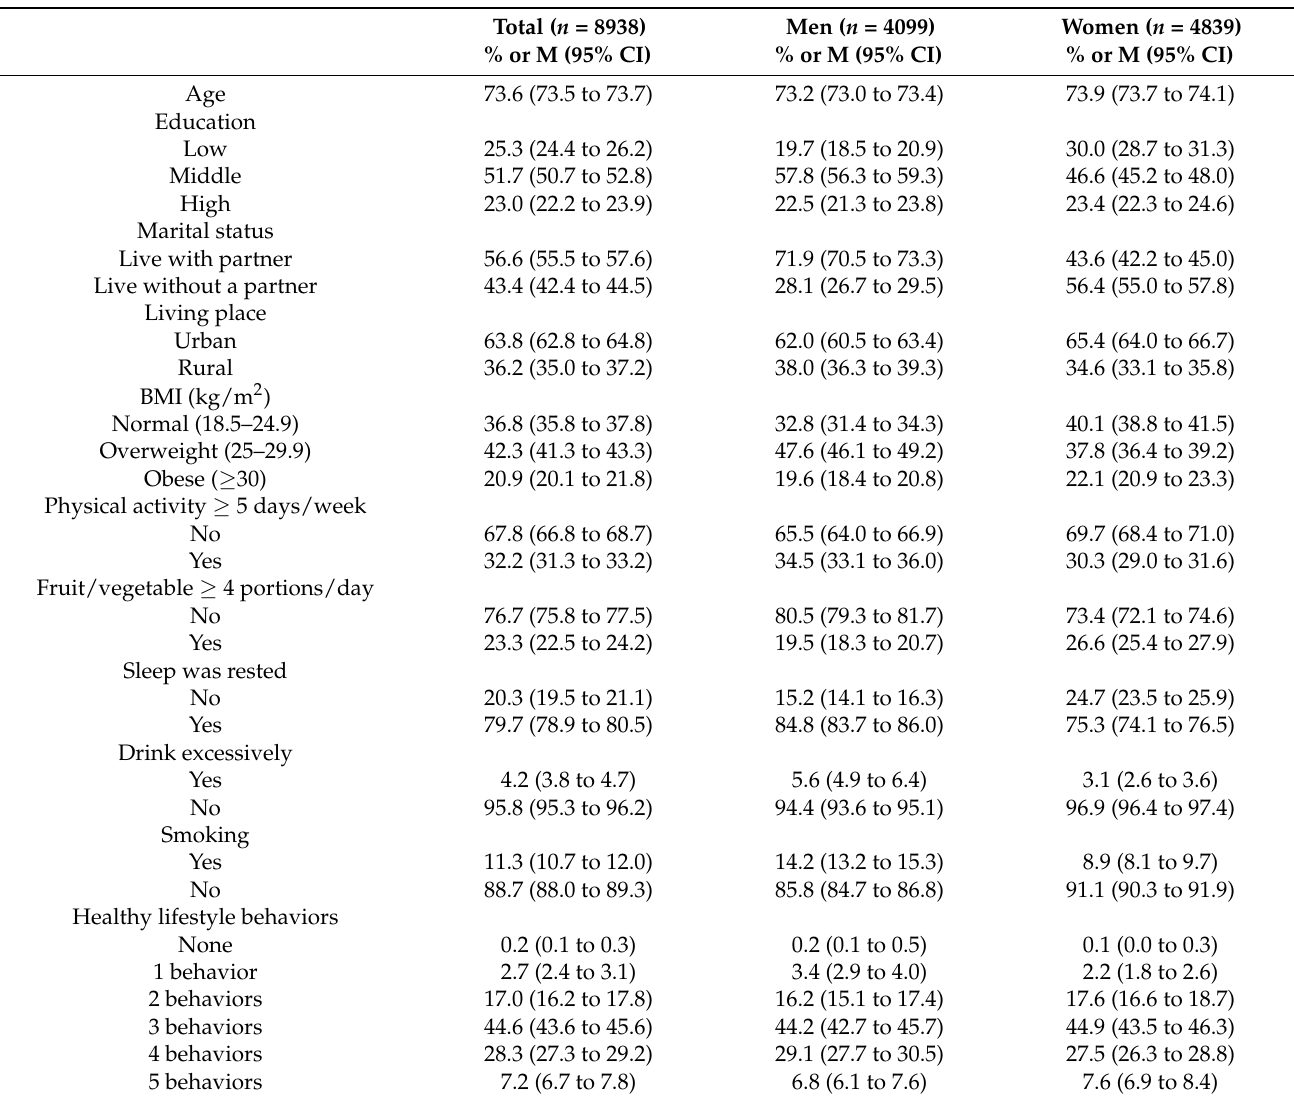
Table 1. Participants’ characteristics for the total sample.